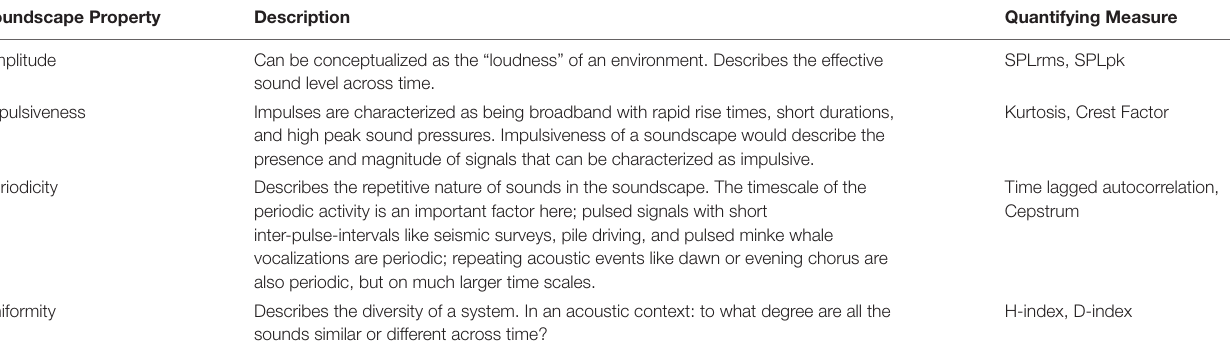
TABLE 2 | Soundscape properties and corresponding metrics, statistical measures, and indices investigated for inclusion in the soundscape code. Soundscape